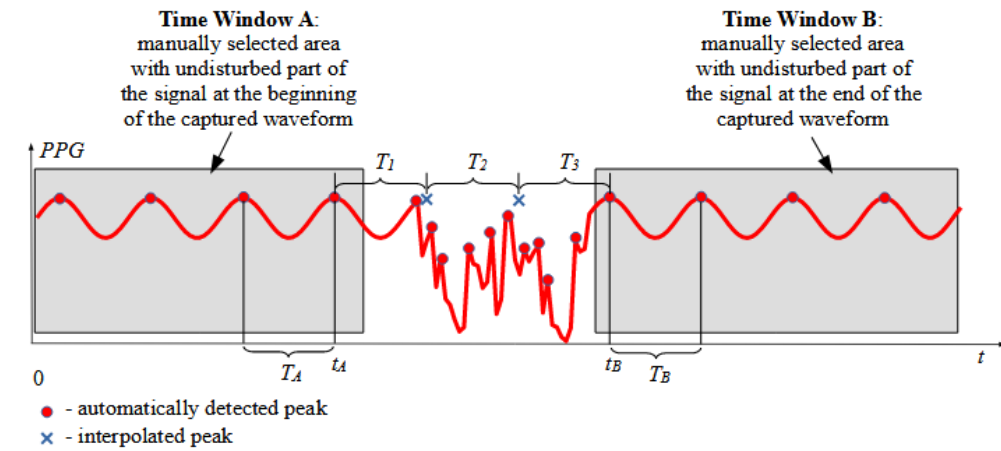
Figure 4. Graphical illustration of calculation of the interpolated peaks’ positions.